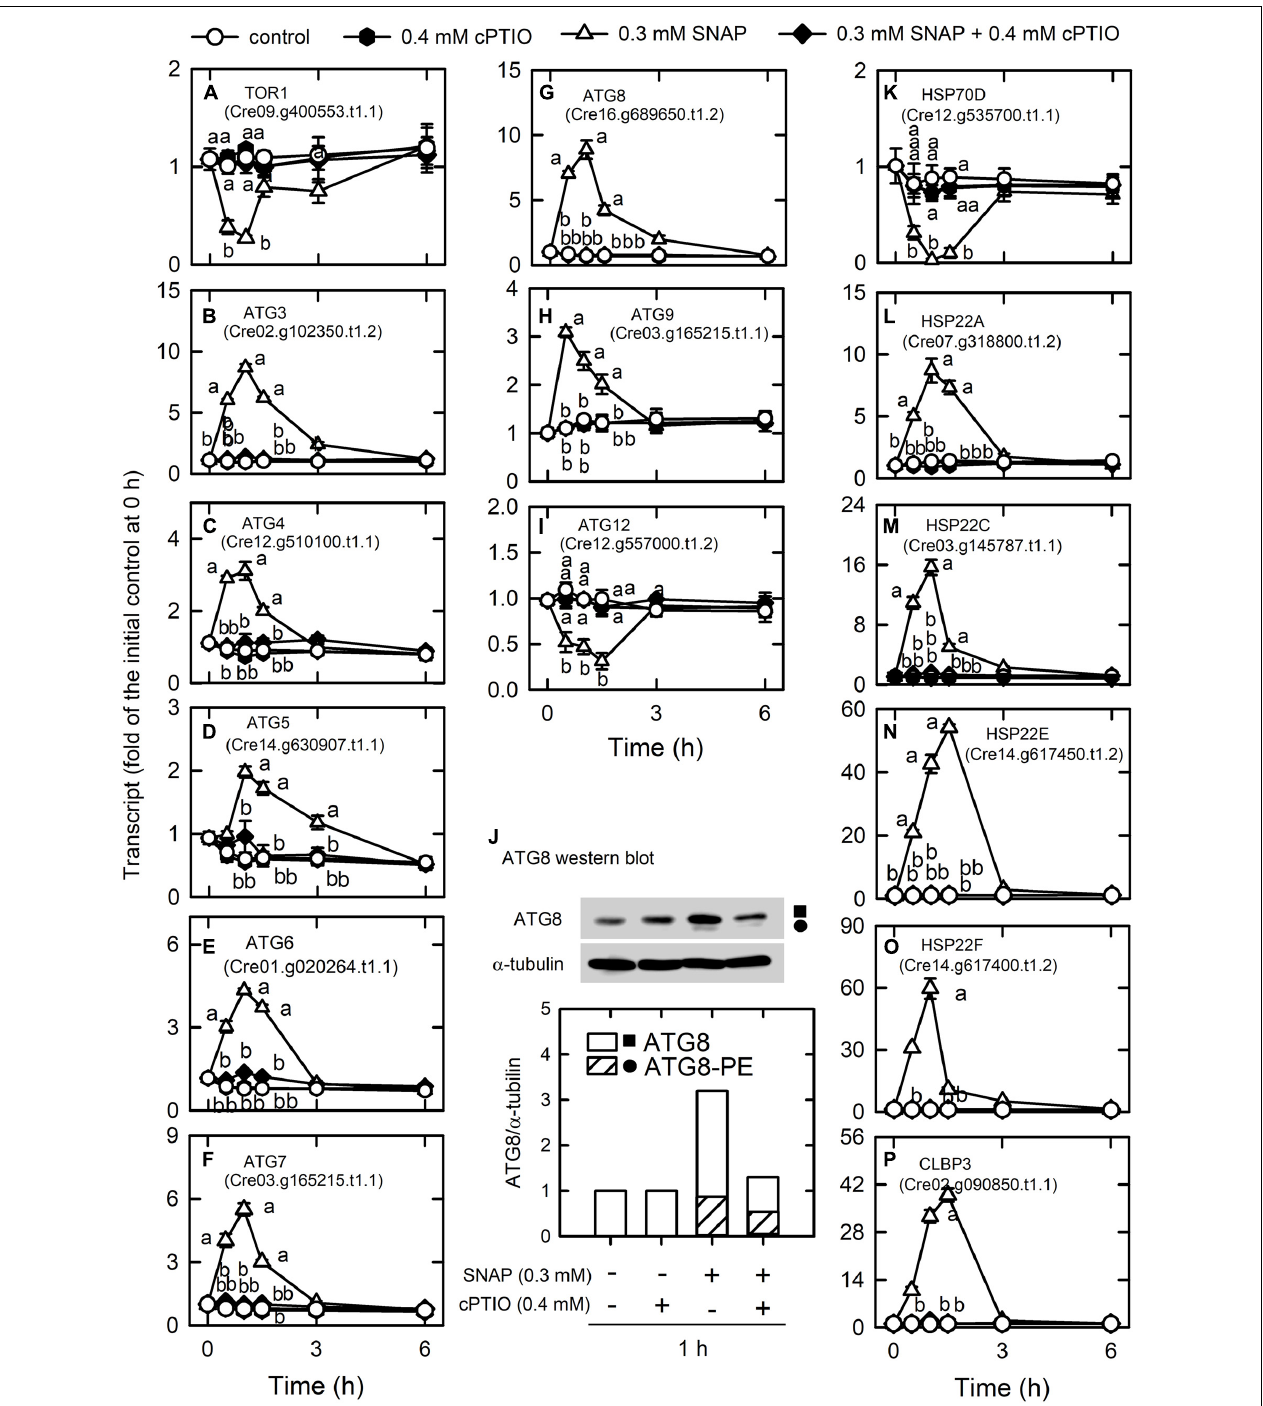
FIGURE 6 | Effects of NO on the expression of genes encoding autophagy proteins. Time-course changes in the transcript abundances of autophagy-related genes and heat-shock proteins and the protein abundances of ATG8 in C. reinhardtii upon exposure to 0.3 mM SNAP in the presence or absence of 0.4 mM cPTIO. (A) TOR1; (B) ATG3; (C) ATG4; (D) ATG5; (E) ATG6; (F) ATG7; (G) ATG8; (H) ATG9; (I) ATG12; (J) ATG8 (square symbol) and ATG8-PE (circle symbol) protein abundances; (K) HSP70D; (L) CLBP3; (M) HSP22A; (N) HSP22C; (O) HSP22E; (P) HSP22F. Data are expressed as the mean ± SD ( n = 3). Different symbols indicate significant differences between treatments (Scheffe’s test, P <